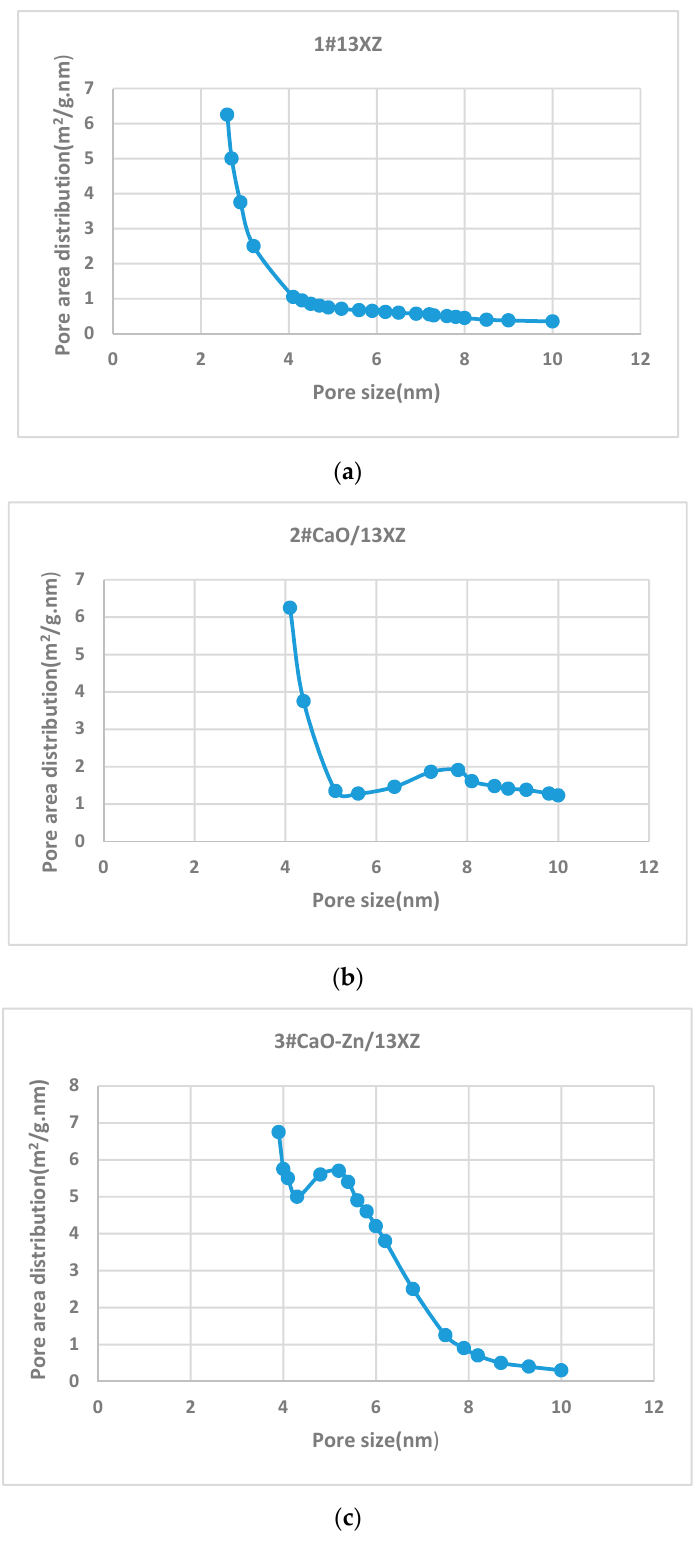
Figure 6. Pore area distributions of: ( a ) 1# 13XZ; ( b ) CaO/13XZ; ( c ) CaO-Zn/13XZ. The occurrence of hysteresis during desorption showed the presence of mesopores The XRD spectra of the nanocomposites are presented in Figure 7, where the spectra (a) for nanomaterial samples 1#, 2# and 3# (Figure 5). The analysis of the pore area distribu- represent the 1# 13XZ nanomaterial. It can be seen that the spectrum shows characteristic peaks of faujasite-type structure tion (Figure 6) for modified 13X zeolite showed a hierarchical pore structure mainly in 2#